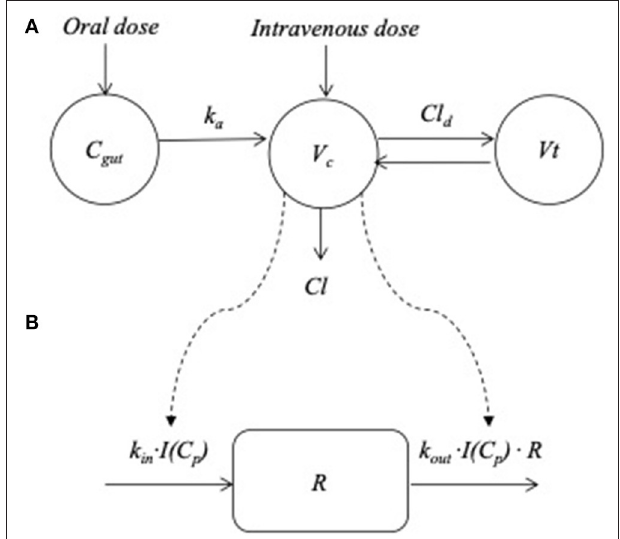
FIGURE 2 | Overview of the pharmacokinetic and pharmacodynamics model. (A) The plasma absorption and disposition model where C gut , k a , V c , V t , Cl, and Cl d represent the drug disposed in the gut, the absorption rate constant from the gut to the central compartment, central and peripheral volume of distribution, clearance and inter-compartmental distribution parameter, respectively. (B) The turnover model describing the prednisolone induced changes in response ( R ). The plasma concentration ( C p ) was used to “drive” the drug mechanism function [ I ( C p )] acting on the turnover rate of response where k in ( t ) , k out and R represent the turnover rate and the fractional turnover rate. For cortisol production of response was inhibited, for lymphocytes loss was stimulated and for neutrophils, loss of response was